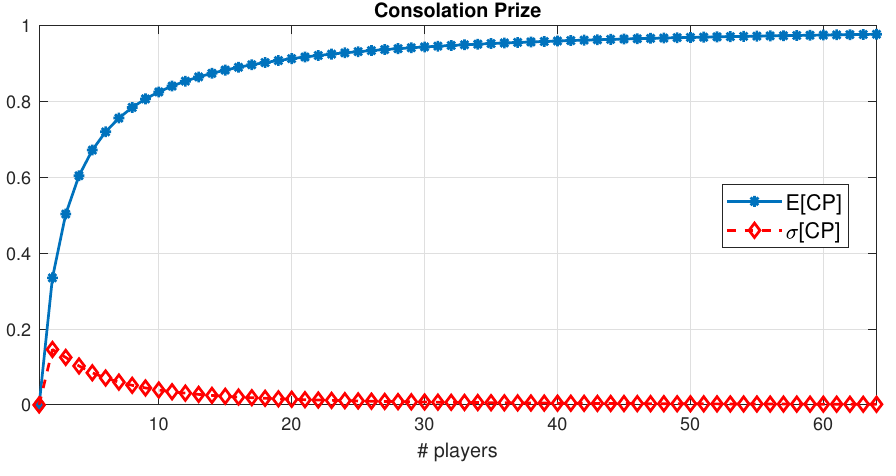
Figure 5. Consolation prize